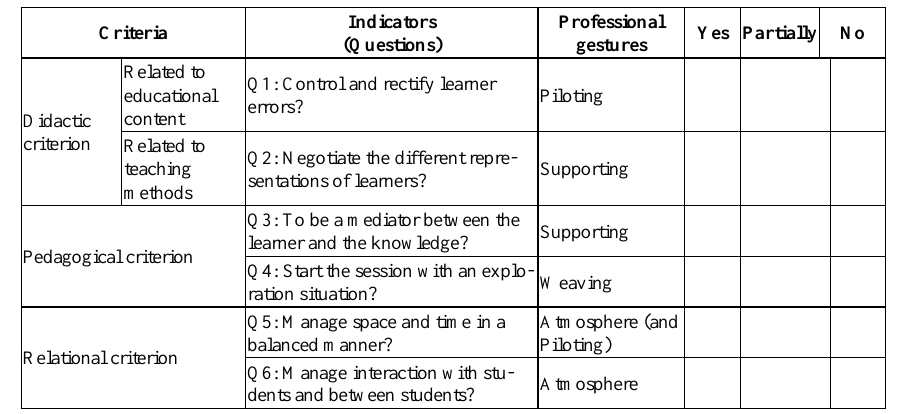
Table 1. Grid for peer review of an intern's classroom